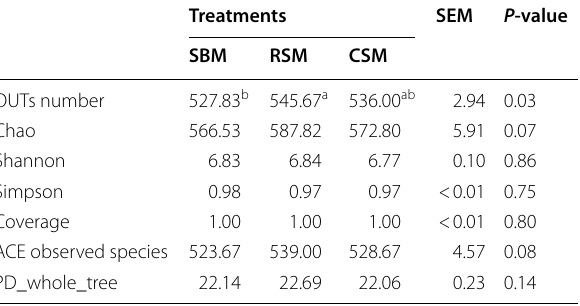
Table 4 Species richness, diversity and evenness indices of rumen bacteria affected by different protein source of